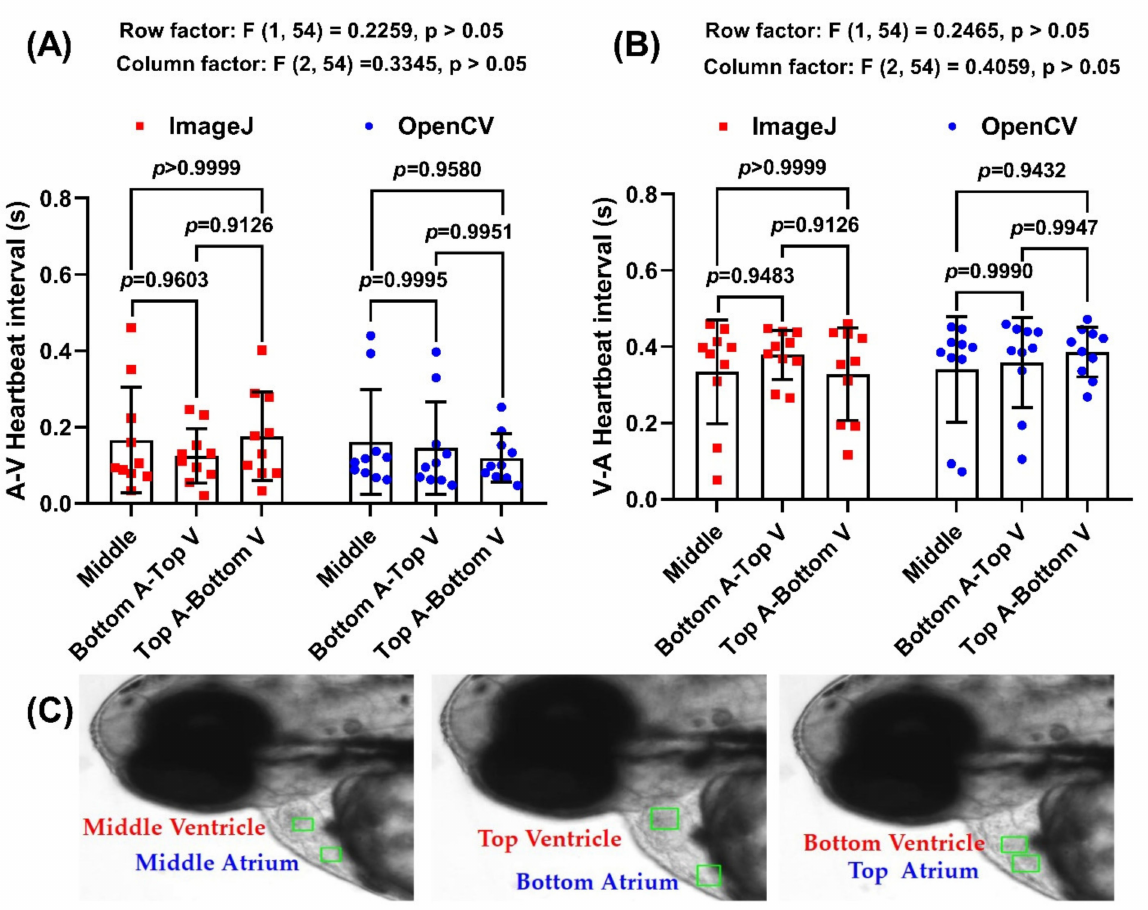
Figure 4. Comparison of Atrium-Ventricle ( A ) and Ventricle-Atrium ( B ) heartbeat interval using ImageJ and OpenCV method. ( C ) Schematic diagram showing the position for ROI selection. Data was processed using Two-Way ANOVA with Tukey comparison method and presented as Mean ± SEM; n =